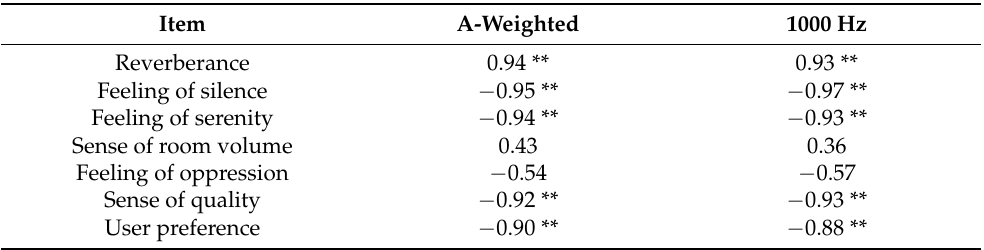
Figure 17. Results of the 1-kHz octave-band sound pressure level on line “d” in each absorption pattern. The dotted line represents the boundary between the front room and evaluation space. Table 10. Correlation coefficients between the sound pressure levels at position “d3” in the evaluation space and psychological value of each evaluation item.